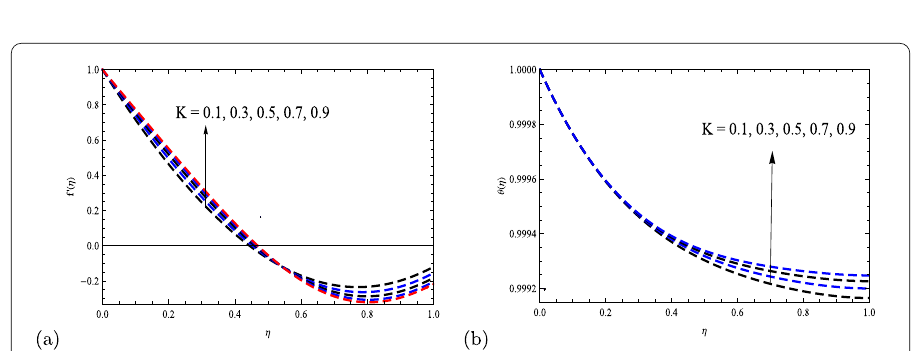
Figure 5 The effect of K on velocity profile and temperature profile with Ma = 5, M = 1, ϒ = 0.027013, Pr = 0.2, Gr = 5, S = 0.2.